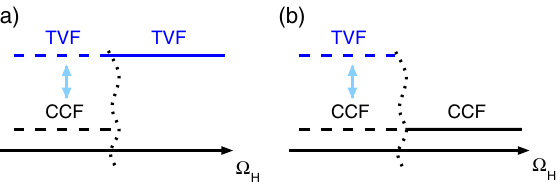
Figure 6. Schematic illustration for stability change with (cid:31) H . Schematic illustration the switch between sub- and supercritical flow states with variation in the driving frequency (cid:31) H (increasing left to right) (cf. Fig.